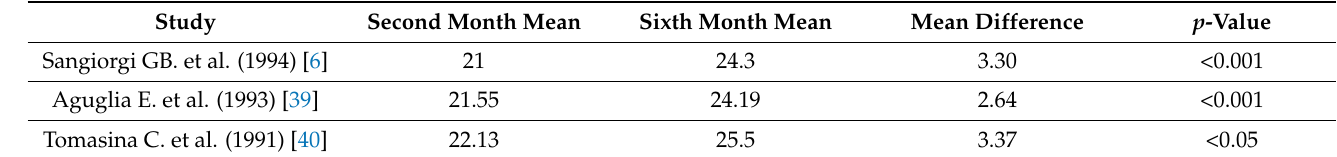
Table 3. A comparison of Mini-Mental State Examination (MMSE) scores between the second and sixth months after the scheduled follow-up period of treatment with choline alphoscerate for patients with